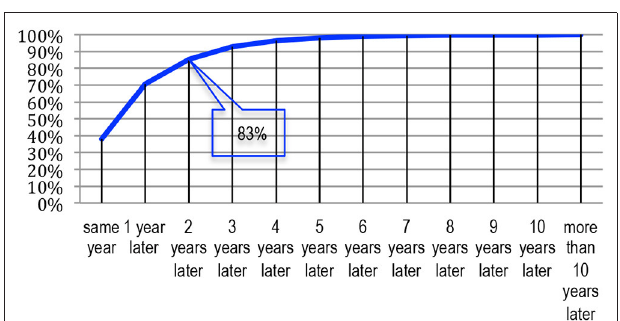
FIGURE 33 | Time delay between publication in conferences and reuse in journals.